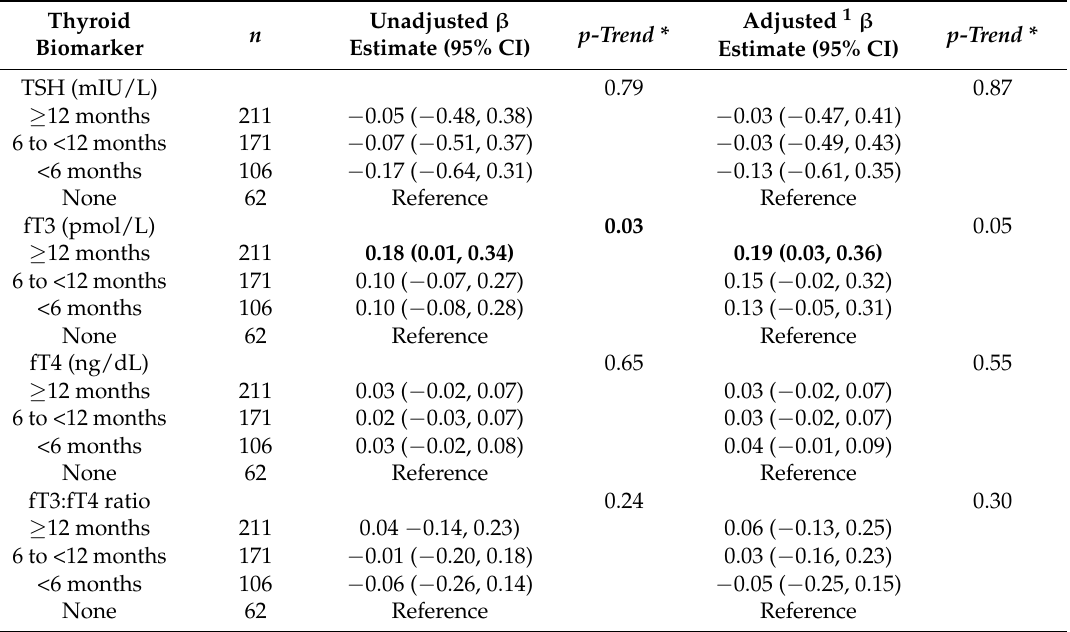
Table 3. Thyroid biomarker levels 9 to 16 years postpartum according to lactation history among women with a history of gestational diabetes, Diabetes & Women’s Health